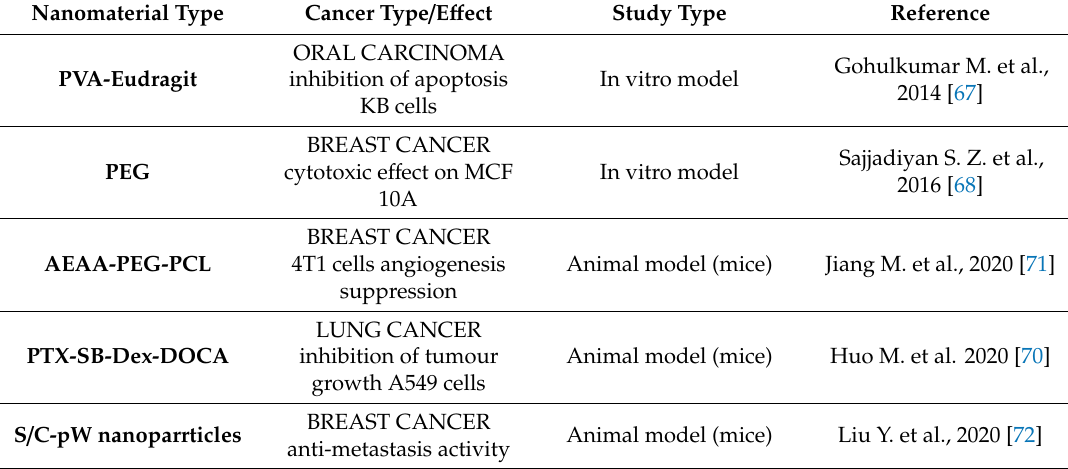
Table 4. Anticancer e ff ect of silibinin nanoparticles in in vitro and in vivo studies.